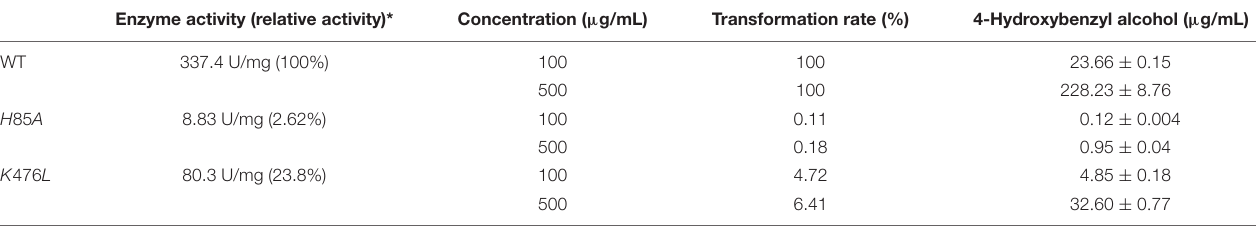
TABLE 4 | Enzyme activity and transformation of gastrodin catalyzed by wild-type (WT) TtBgl3 and the mutants of H 85 A and K 476 L . Enzyme activity (relative